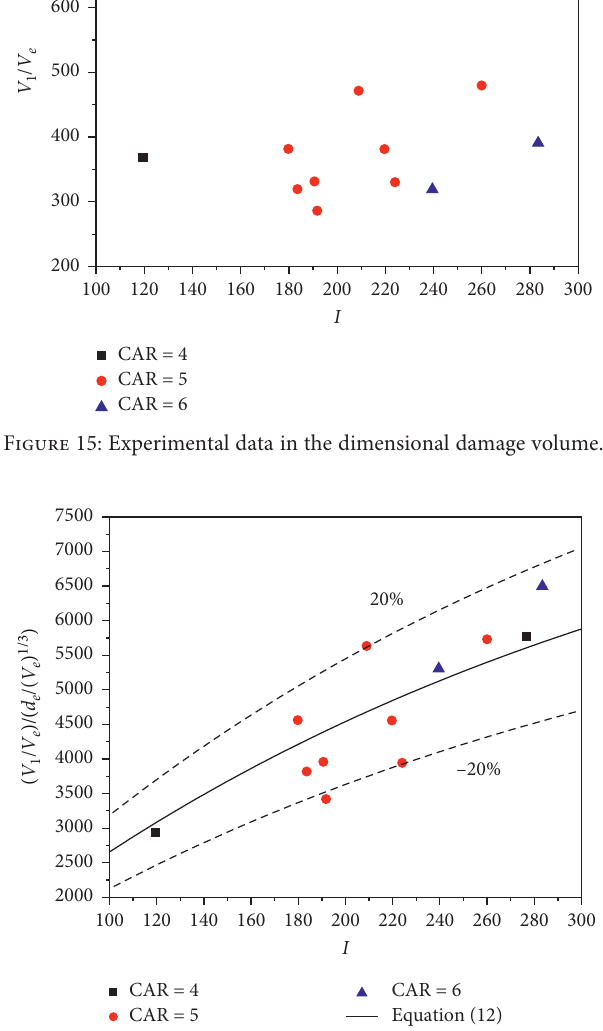
Figure 16: Relationship between equation (12) and experimental